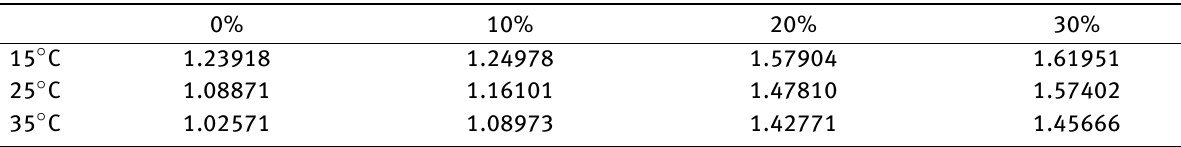
Table 4: ZSV of energetic materials contenting RDX at different temperature ( × 10 6 Pa · s, 1.5ml/g).